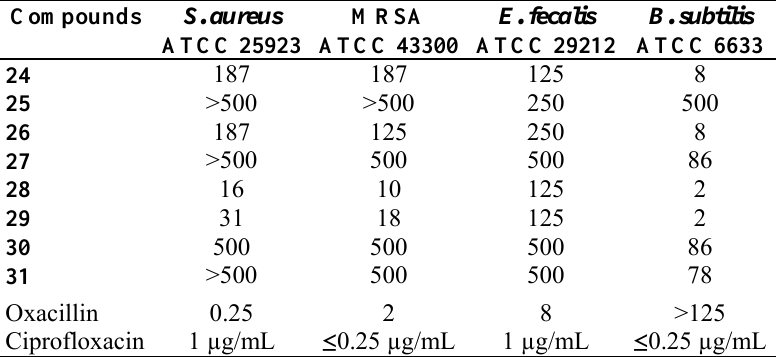
Table 2. MIC ( μ g/mL) values for BZS compounds 24 - 31